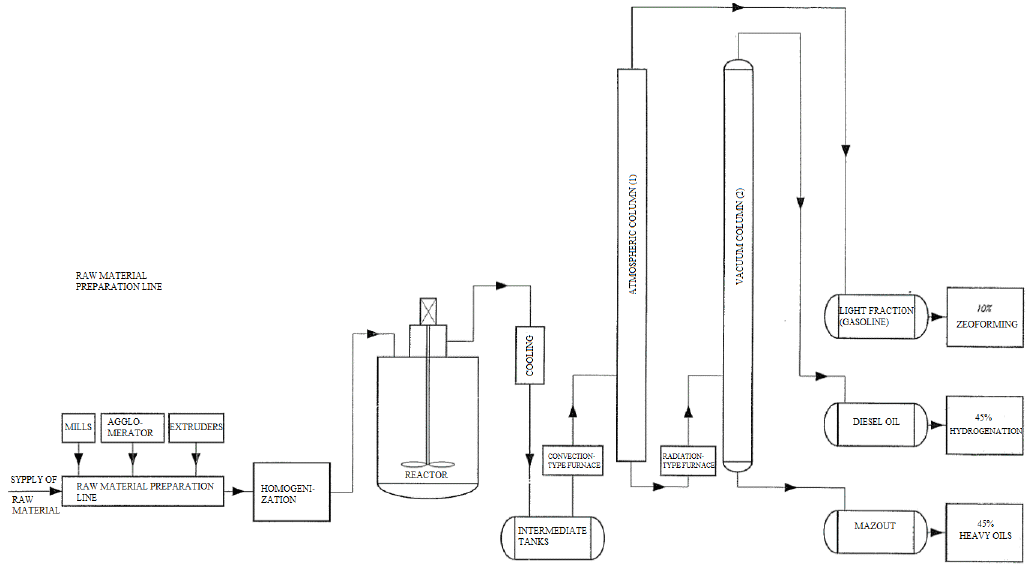
Figure 3. Schematic diagram of the depolymerization line in the Agrob-Eko company. In this case, having gone through the sorting line, the raw material is subjected to homogenization and depolymerization like in the Toru´n plant. Here, however, tank mixers are used for this purpose. This involves the need to pause the process at certain intervals to clean the inside of the tanks of accumulated contaminants. Further on, there are heaters and distillation and rectification columns. Fractionated products, gasoline, oils and heavy fractions (mazout) are obtained. The application of a system of columns makes it possible to achieve specific properties of the product, but as deposits of impurities / contaminants are not e ff ectively removed earlier, the plates of the columns get clogged and need systematic cleaning. The packaging waste recycling plant in Toru´n is free from such problems. The issue of the removal of contaminants was solved successfully. At the same time, the system intended for the separation of fractions was